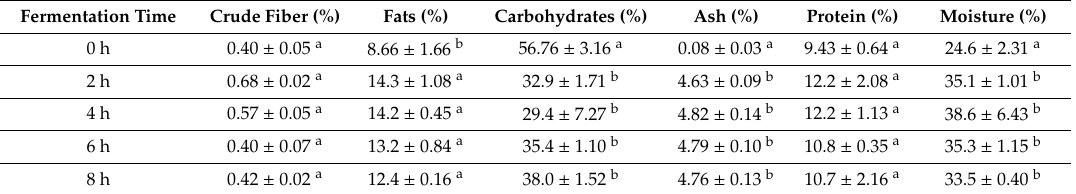
Figure 6 . Picture of transversal cut of two of the baked biscuits. 0 h control biscuit, 4 h biscuit made from flour fermented for 4 h. In terms of color, there was no statistical difference in the parameters as can be seen in Table 1. However, there exists a browning effect with a statistical difference between 0 h (blank) and the rest of the biscuits. Contrary results have been obtained where flour formulations were substituted with fermented chestnut flour [6]. L* values ranged from 56.70 to 50.33 increasing along with the chestnut sourdough substitution. However, fermentation times were considerably higher (120 h) than those used in this paper. Similarly, L* values for biscuits made with fermented Agaricus bisporus polysaccharides showed a significant difference between their treatments [14]. L* values obtained in this investigation could be explained by the fat content along with maillard reactions [14,32].